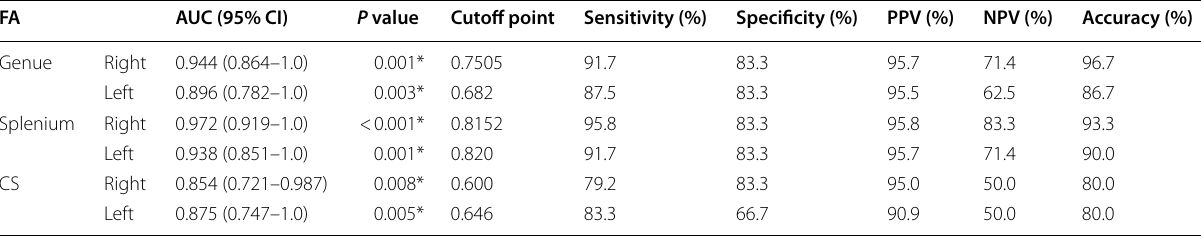
*Significance of FA alone, MD alone and combined FA and